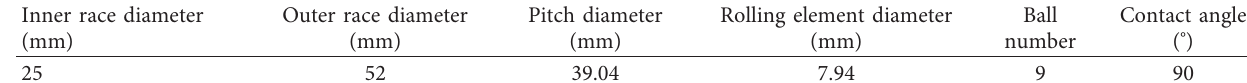
Table 6: Bearing parameters.